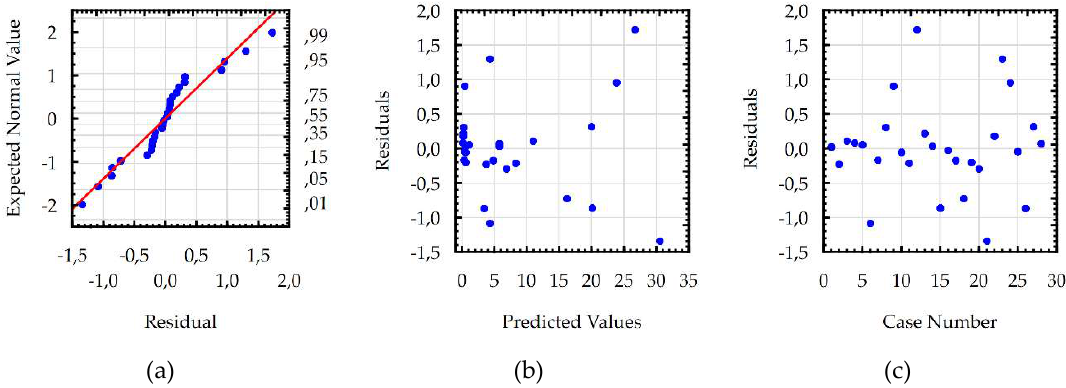
Figure 13. The plots to check the model MRR: ( a ) the normal plot of residuals; ( b ) the residuals versus the predicted values; and ( c ) the residuals versus the case values.